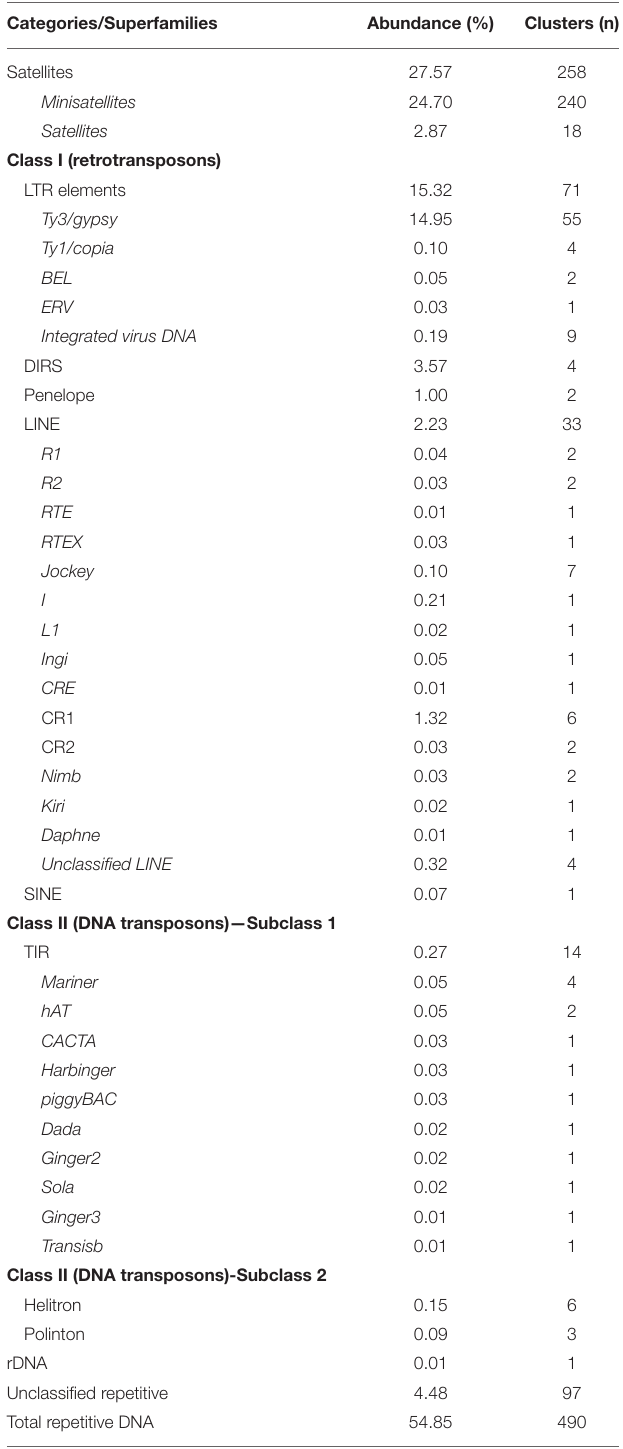
TABLE 3 | Major types of repetitive DNA in P. leptodactylus (classification according to Wicker et al., 2007).